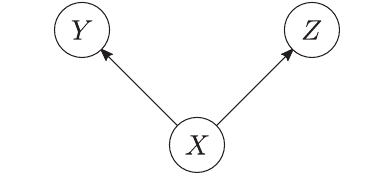
FIG. 1. A causal structure represented as a directed acyclic graph depicting that X is the complete common cause of Y and Z .